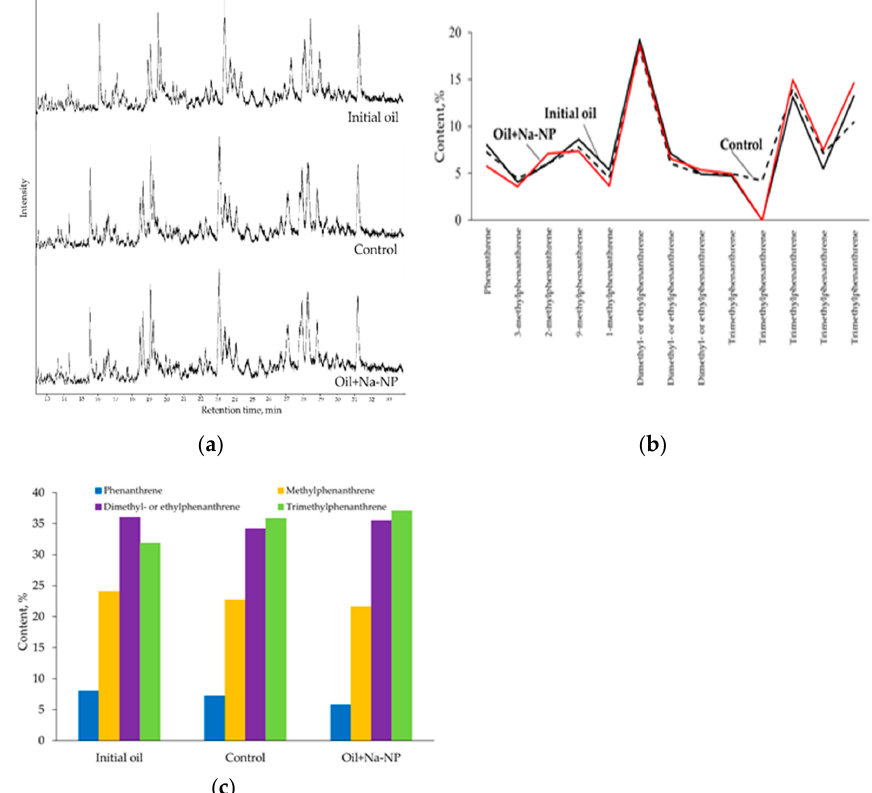
Figure 9. GC-MS spectra of ( a ) phenanthrene and its homologues in the aromatic fraction, ( b ) and ( c ) relative content of phenanthrene types. The viscosity of the heavy oil samples before and after aquathermolytic upgrading in the absence and presence of Na NP was studied at various temperatures. The tempera- ture-dependent dynamic viscosity of the oil samples is compared in Figure 10.